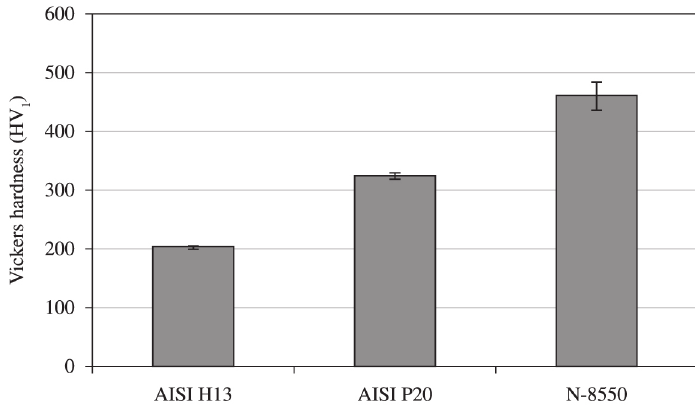
Figure 1. Vickers Hardness Values for the three materials as received from the manufacturer, without nitriding